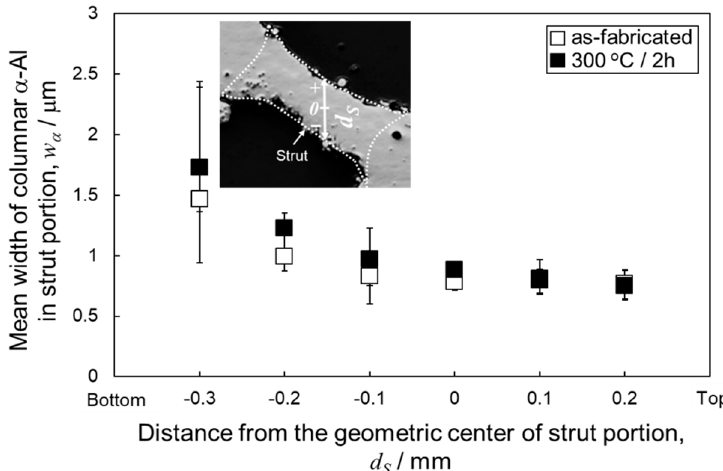
Figure 11. Changes in the mean width of columnar α -Al phases as a function of the vertical distance from the geometric center ( ds ) in the strut portion of as-manufactured and 300 °C annealed specimens.